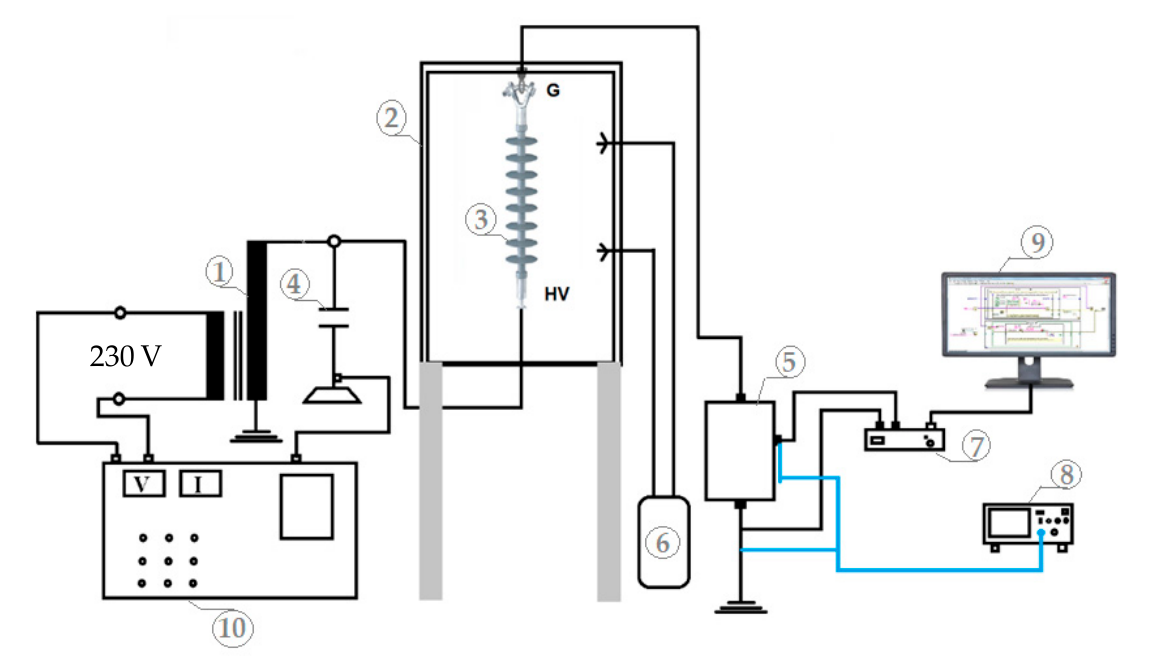
Figure 2. Experimental test setup consisting of (1) Transformer; (2)Test chamber; (3)Insulator sample; (4) Capacitive divider; (5) Shunt resistor; (6) Fog generator; (7) Data acquisition system (DAQ); (8) Oscilloscope; (9) Computer; (10) Control panel.